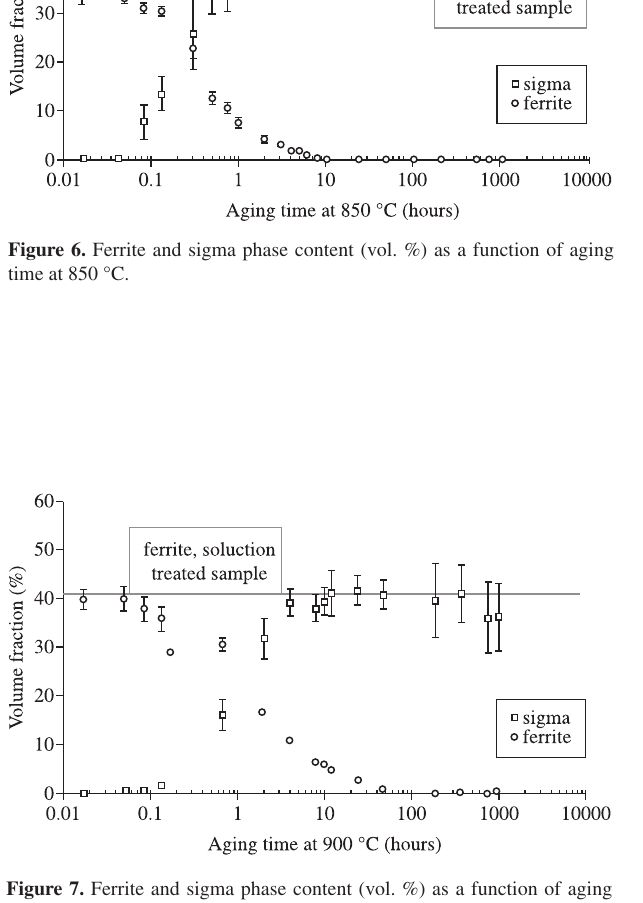
Figure 10. TTP diagram for sigma phase between 700 and 900